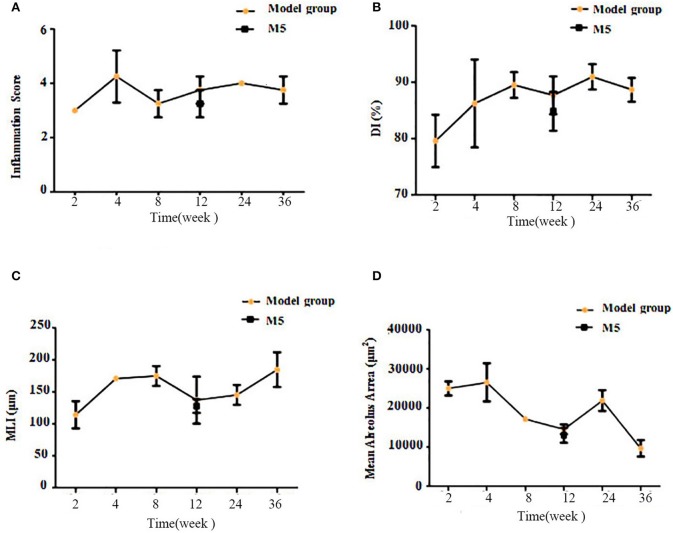
Comparison of lung tissue pathology findings between the model groups, based on semi-quantitative analysis of airway inflammation scores and emphysema indicators. (A) The airway inflammation score. (B) The destructive index (DI). (C) The mean linear intercept (MLI). (D) The mean alveolus area.